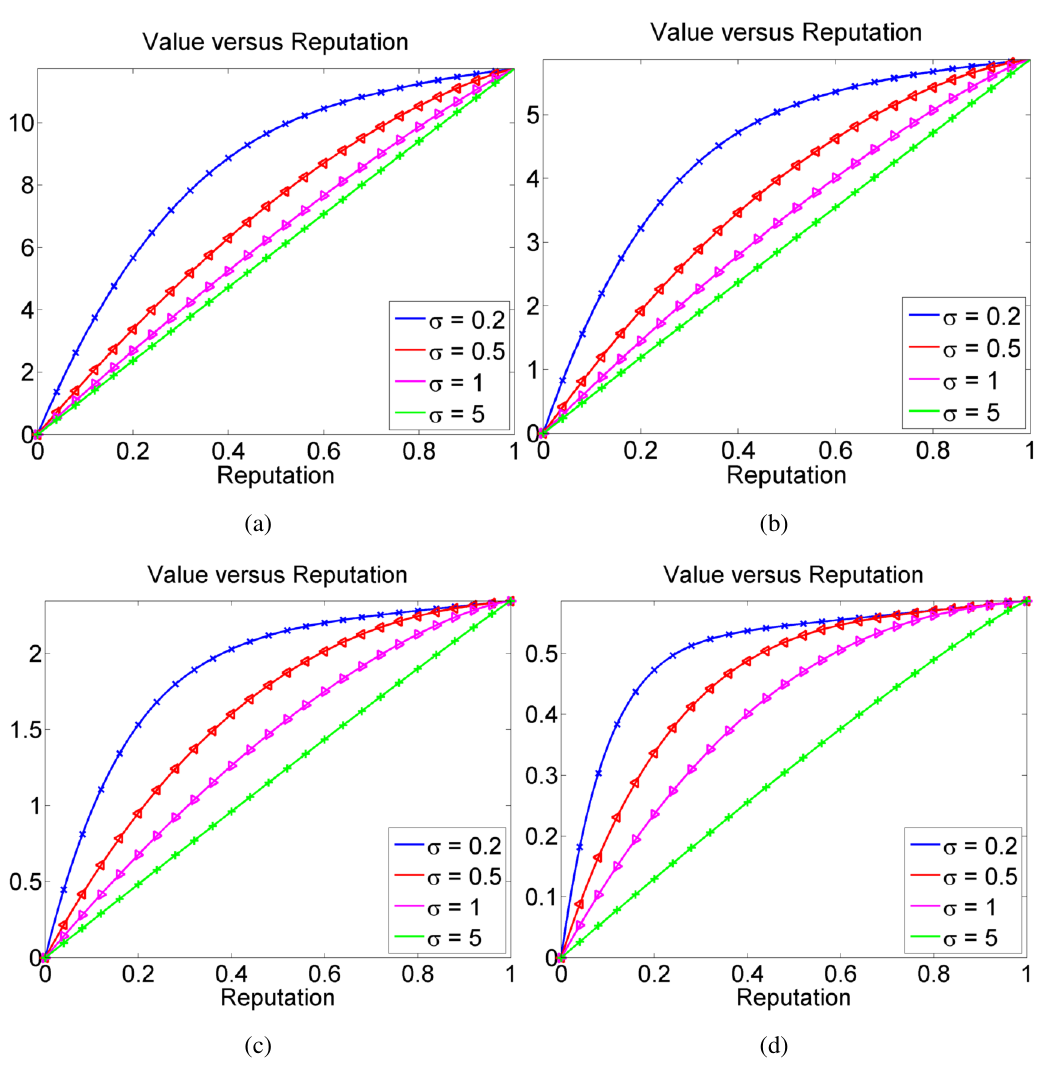
Figure 1. A plot of several numerical solutions V ( y ) for the reduced boundary value problem Equation (17) are shown with A = 1 , C = 0 . 15 , and (cid:15) = 0 . 02 . ( a ) ρ = 0 . 1 ; ( b ) ρ = 0 . 2 ; ( c ) ρ = 0 . 5 ; ( d ) ρ = 2 . 0